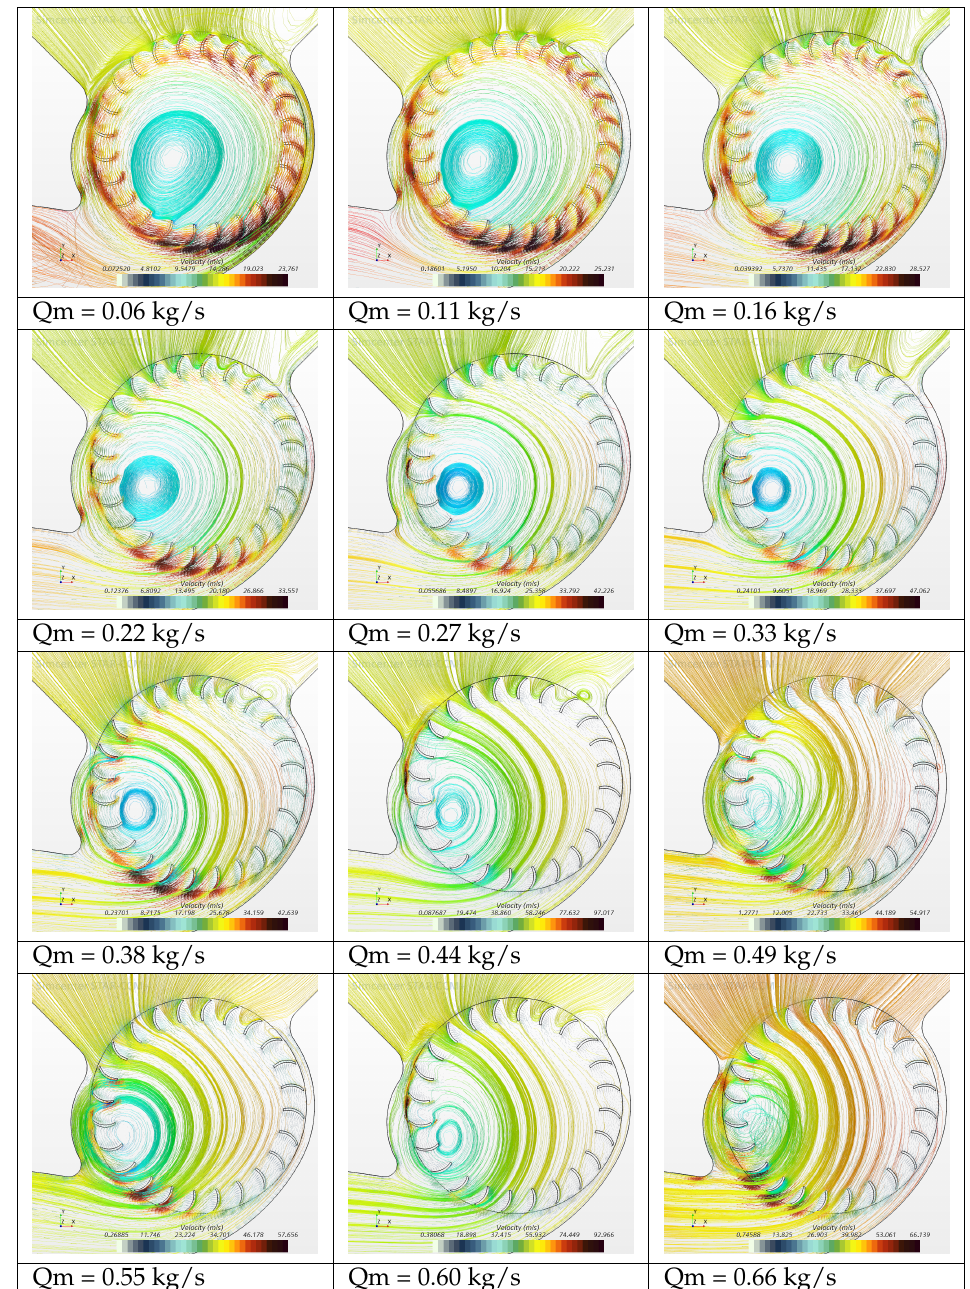
Figure 22. Streamlines colored by velocity for 2250 rpm using CFD analysis. To investigate the efficiency, we measured the average vortex radius in each simulation and deduced the value of k vor each time according to kr vor . The most satisfactory finding is that for each case, k vor is around the same value, as indicated in Figures 25 and 26, which means that k vor specific to the Eck/Laing geometry is equal to